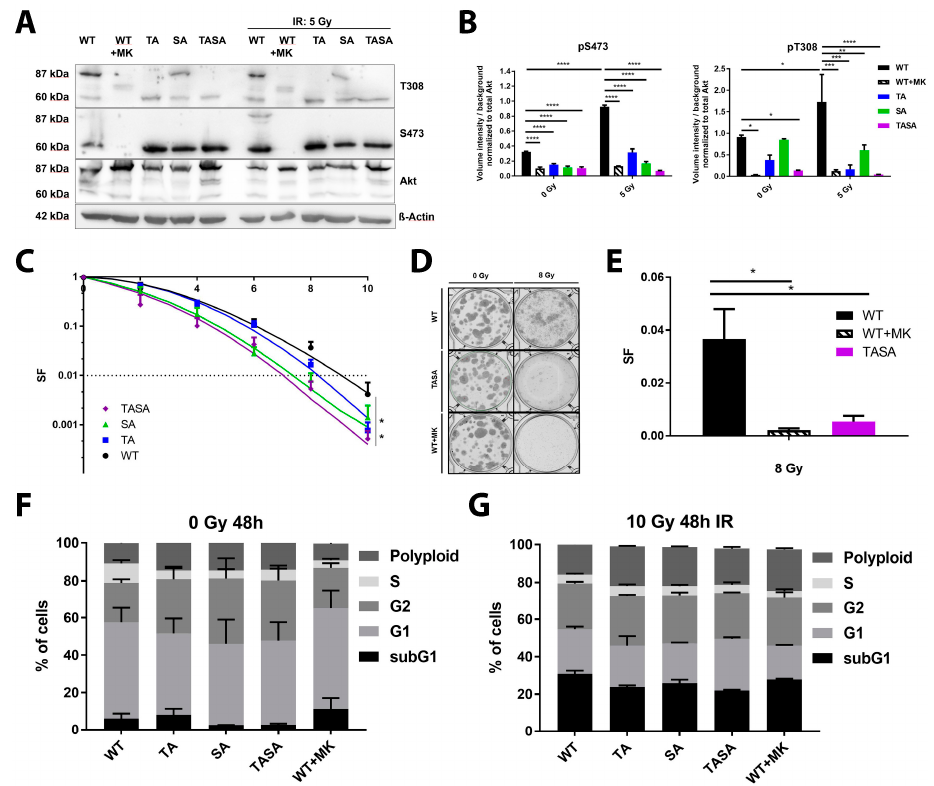
Figure 2. Expression of phosphorylation-deficient Akt1 mutants reduced cancer cell radiosensitivity. TrC1 were exposed to irradiation with 5 Gy. ( A ) The phosphorylation status (S473, T308) of the Akt1 mutants at 0.5 h after irradiation depicted by western blot analysis. Lower bands (60 kDa) show endogenous Akt; upper bands (87 kDa) depict eGFP-fused Akt1-mutants. ( B ) The quantification of pS473 and pT308 western blots of 3 independent experiments shows the volume intensity normalized to the background. The volume intensity of phosphorylated Akt was normalized to the volume intensity of total amount of Akt. ( C , D ) Long-term survival (survival fraction, SF) altered by Akt1 mutants upon IR (0–10 Gy). Akt1-TASA showed significantly reduced survival upon IR. Pictures depict a standard 6-well cell culture plate. ( E ) Long-term survival in Akt1-WT expressing cells treated with 4 µ M MK-2206 for 16 h before IR (WT + MK) compared to the effect evoked by Akt1-WT and Akt1-TASA expression without additional treatment. Data represent SF upon 8 Gy. * p < 0.05, ** p < 0.01, *** p < 0.001, **** p < 0.0001; ANOVA test with Tukey correction. ( F , G ) Quantification of cell cycle distribution in non-irradiated ( F ) and with 10 Gy irradiated ( G ) Akt1-WT, Akt1-TA, Akt1-SA, Akt1-TASA expressing cells and Akt1-WT expressing cells treated with an MK-2206 inhibitor (4 µ M; 16 h incubation; WT + MK) were analyzed by flow cytometry after 48 h incubation. Data show mean values from 3 independent